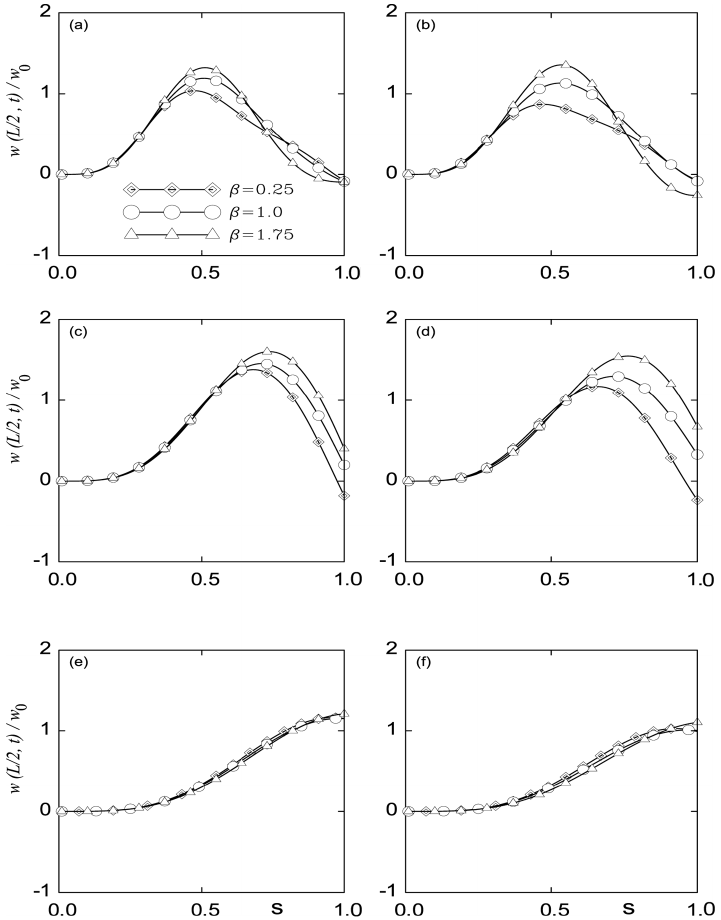
Fig. 3. Dynamic response ( w ( L 2 ,t ) /w 0 ) for a fi xed- fi xed beam: (a) α = 0.25, ζ n = 0.1, (b) α = 0.25, ζ n = 0.2, (c) α = 0.5, ζ n = 0.1, (d) α = 0.5, ζ n = 0.2, (e) α = 1, ζ n = 0.1, (f) α = 1, ζ n =